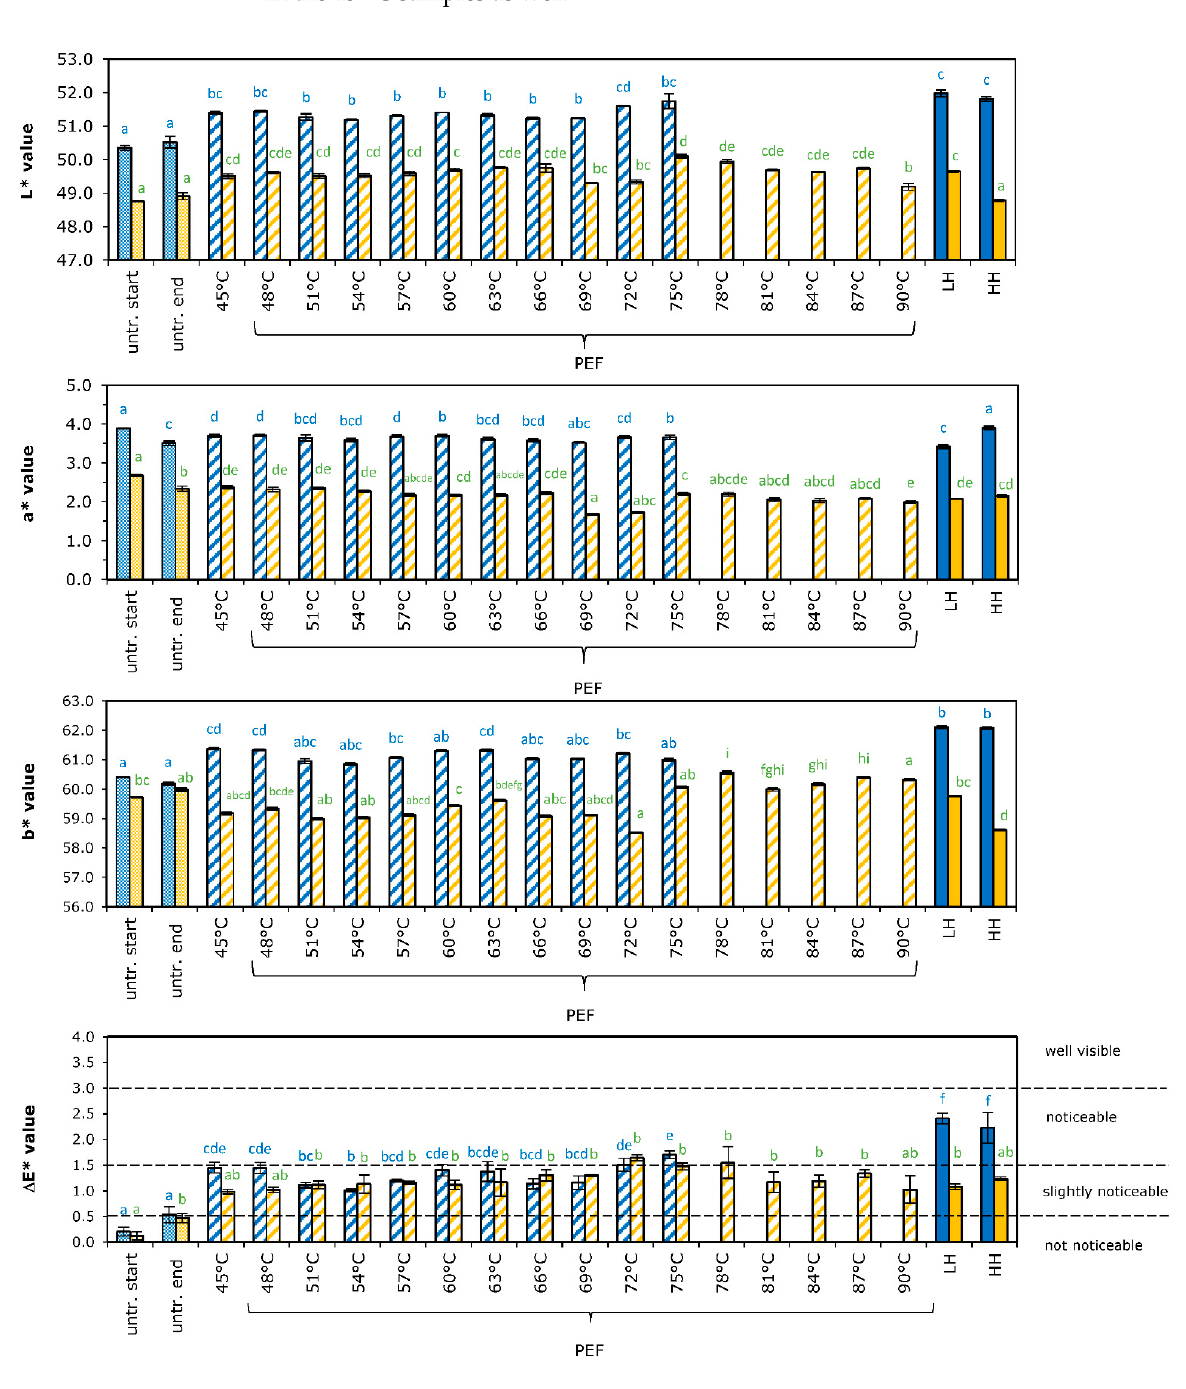
Figure 2. Effect of PEF and thermal processing on color of orange juice, according to Hunterlabs L* , a*, and b*- value and total color difference ( ∆ E ). Blue bars represent juice A, orange bars represent juice B. Values of untreated juice at start and end of the day are given. Results of various moderate intensity PEF treatment are given according to the maximum temperatures applied, using an E = 2.7 kV/cm (blue) and 0.9 kV/cm (orange). Thermal treatments are indicated as LH for low heat treatment (75 °C—20 s) and HH for high heat treatment (95 °C—20 s). Bars represent the average of three measurements with standard deviation. Statistical differences between the treatments are indicated with a letter per juice (color), with matching letters showing no significant difference.